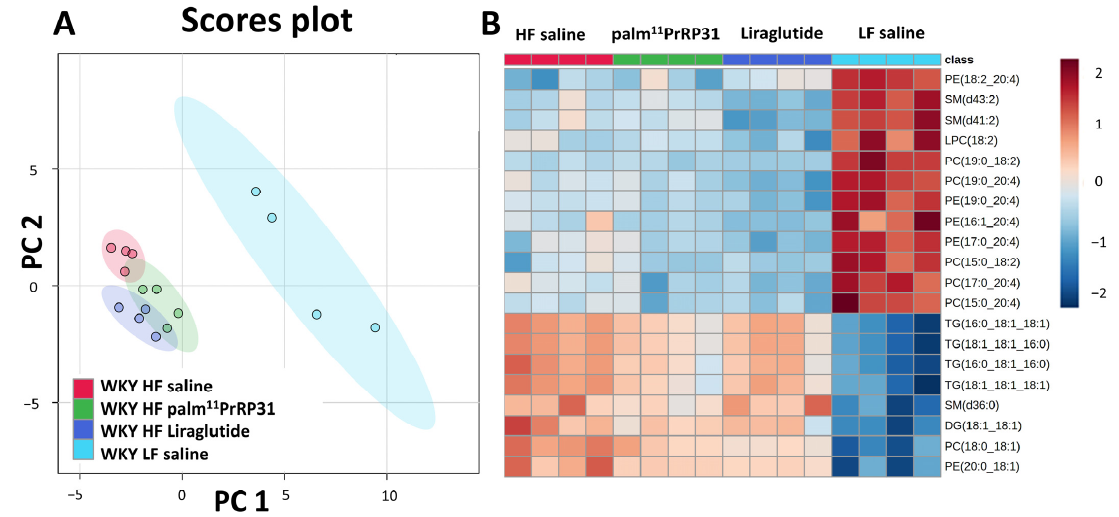
Figure 8. ( A ) PCA score plot based on lipid profiling of WKY LF saline, WKY HF saline, WKY HF liraglutide and WKY HF palm 11 -PrRP31 rats. ( B ) Heatmap of top 20 lipid features based on one-way ANOVA rankings.